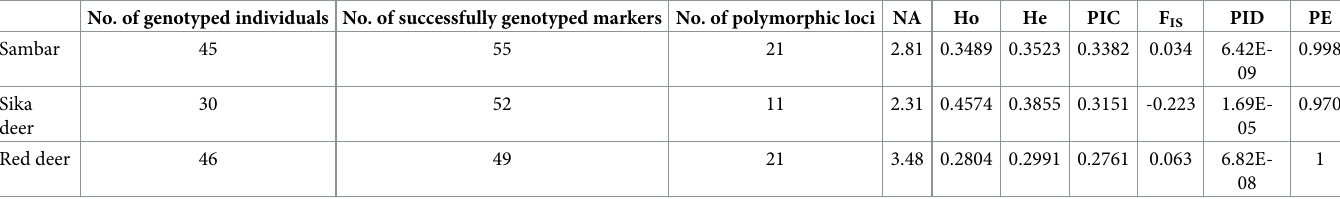
NA: Number of different alleles; Ho: Observed heterozygosity; He: Expected heterozygosity; PIC: Polymorphic information content; PID: Multilocus probability that